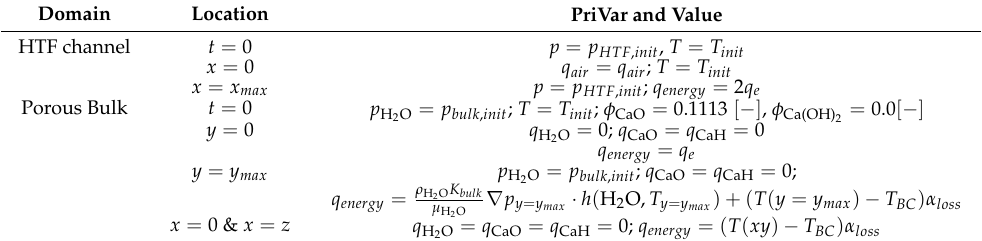
Table 1. Boundary and initial conditions with: q air source term for the component air, q H source term, q Ca(OH) Ca(OH) 2 source term, q CaO CaO source term, q e energy source term. The initial 2 temperature for all simulation cases is T init = 773 [ K ] .